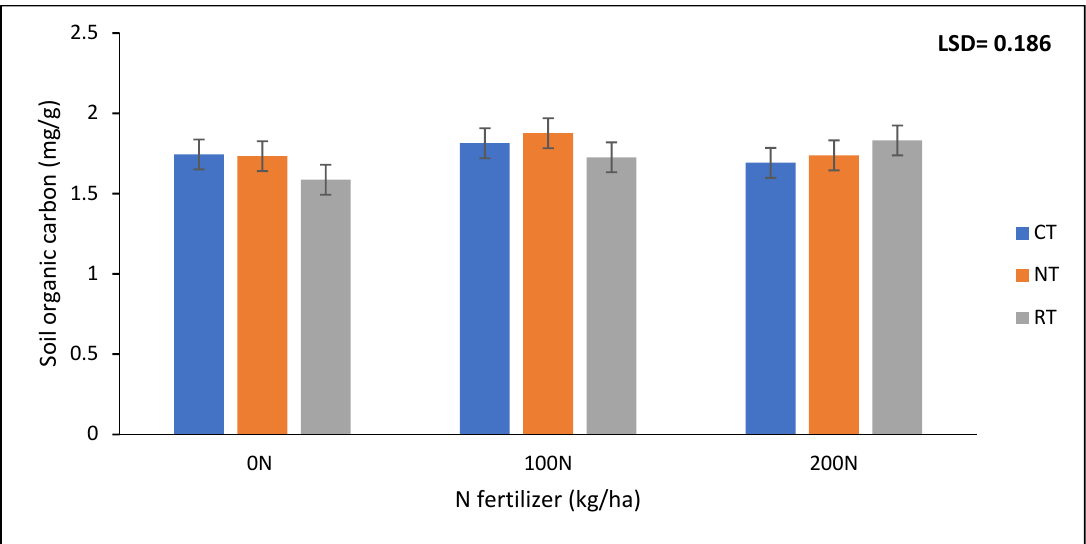
Figure 5. Soil organic carbon (SOC) at three different tillage treatments of no-till (NT), rotational tillage (RT), and conventional tillage (CT) after 17 years of trial establishment.